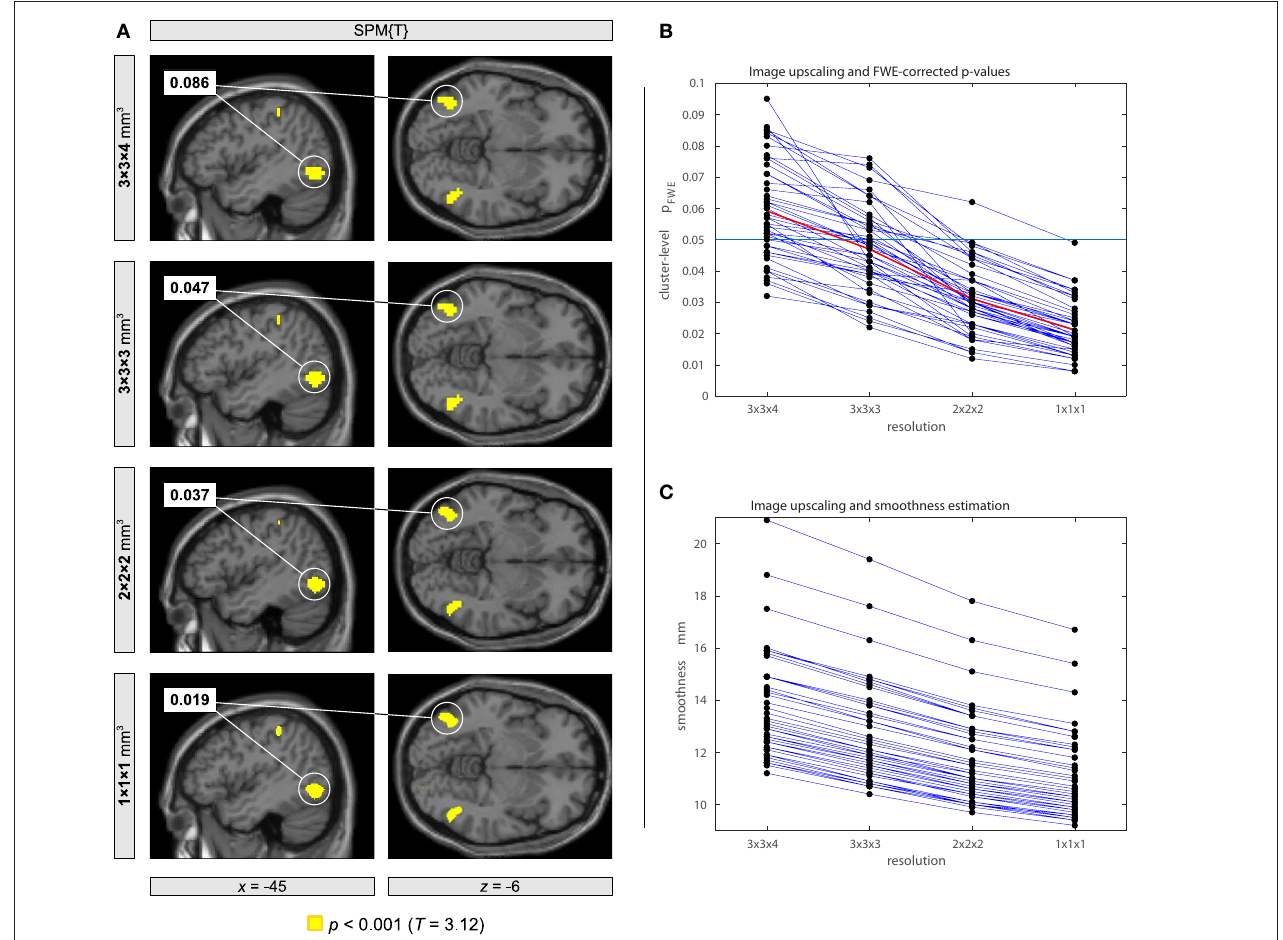
FIGURE 1 | Impact of using different image resolutions onto family-wise error (FWE) corrected p -values with the analysis of resting-state fMRI data using a fake on-off block design. The statistical model included an experimental condition with 18 blocks with a block length of 20s using an onset every 40 s. The same statistical analysis was performed with different image resolutions obtained within the normalization step in SPM12 followed by a subsequent spatial smoothing of 8-mm full width at half maximum. (A) Orthogonal brain sections of an individual subject showing a cluster of brain activity that becomes significant when using image upscaling. (B) Systematic decrease of FWE corrected p -values with increasing image resolution for each participant. The plot shows p -values for a randomly selected cluster with p < 0.1 for each participant. On average, p -values became smaller than the half size of the original value (see line plotted in red color). (C) Systematic decrease of the estimated smoothness when using image